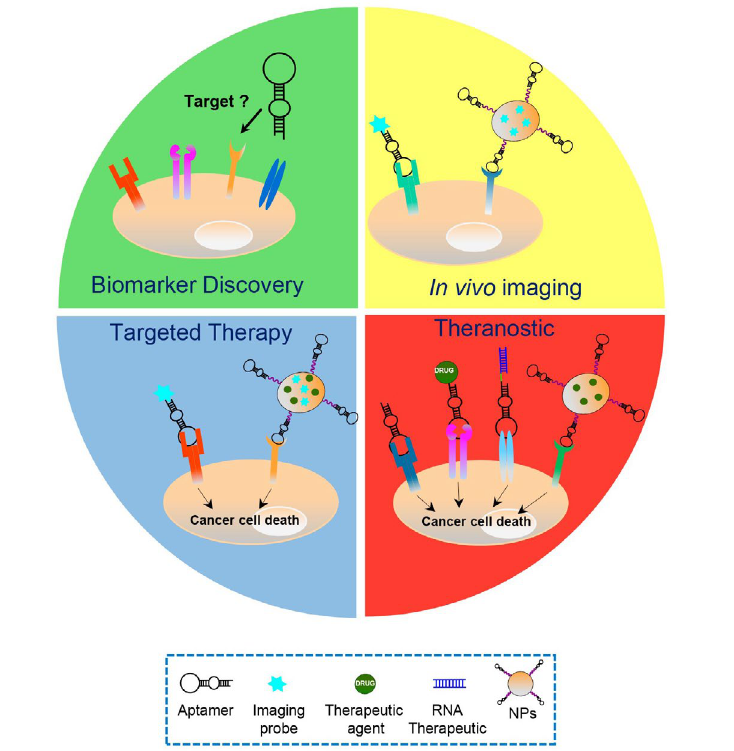
Figure 2. Aptamers’ applications in cancer treatment. Schematic representation of the various cancer applications of aptamers, including biomarker discovery, in vivo imaging, targeted therapy and theranostic approaches, which play key roles in the personalized cancer therapy. Aptamers have been used as: i) recognition agents for biomarkers discovery; ii) imaging agents upon conjugation to fluorescent probes, radionuclides or nanoparticles (NPs) functionalized with biomedical imaging agents; iii) stand-alone therapeutics or delivery agents for chemotherapeutics, RNA therapeutics and drug-loaded NPs; and iv) theranostic agents, upon conjugation to imaging agents (in case the aptamer itself has anti-tumor activities) or NPs loaded with both drug and imaging